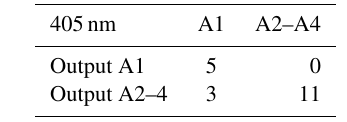
Table 4. Output of the wood category identification for 405nm. 405nm